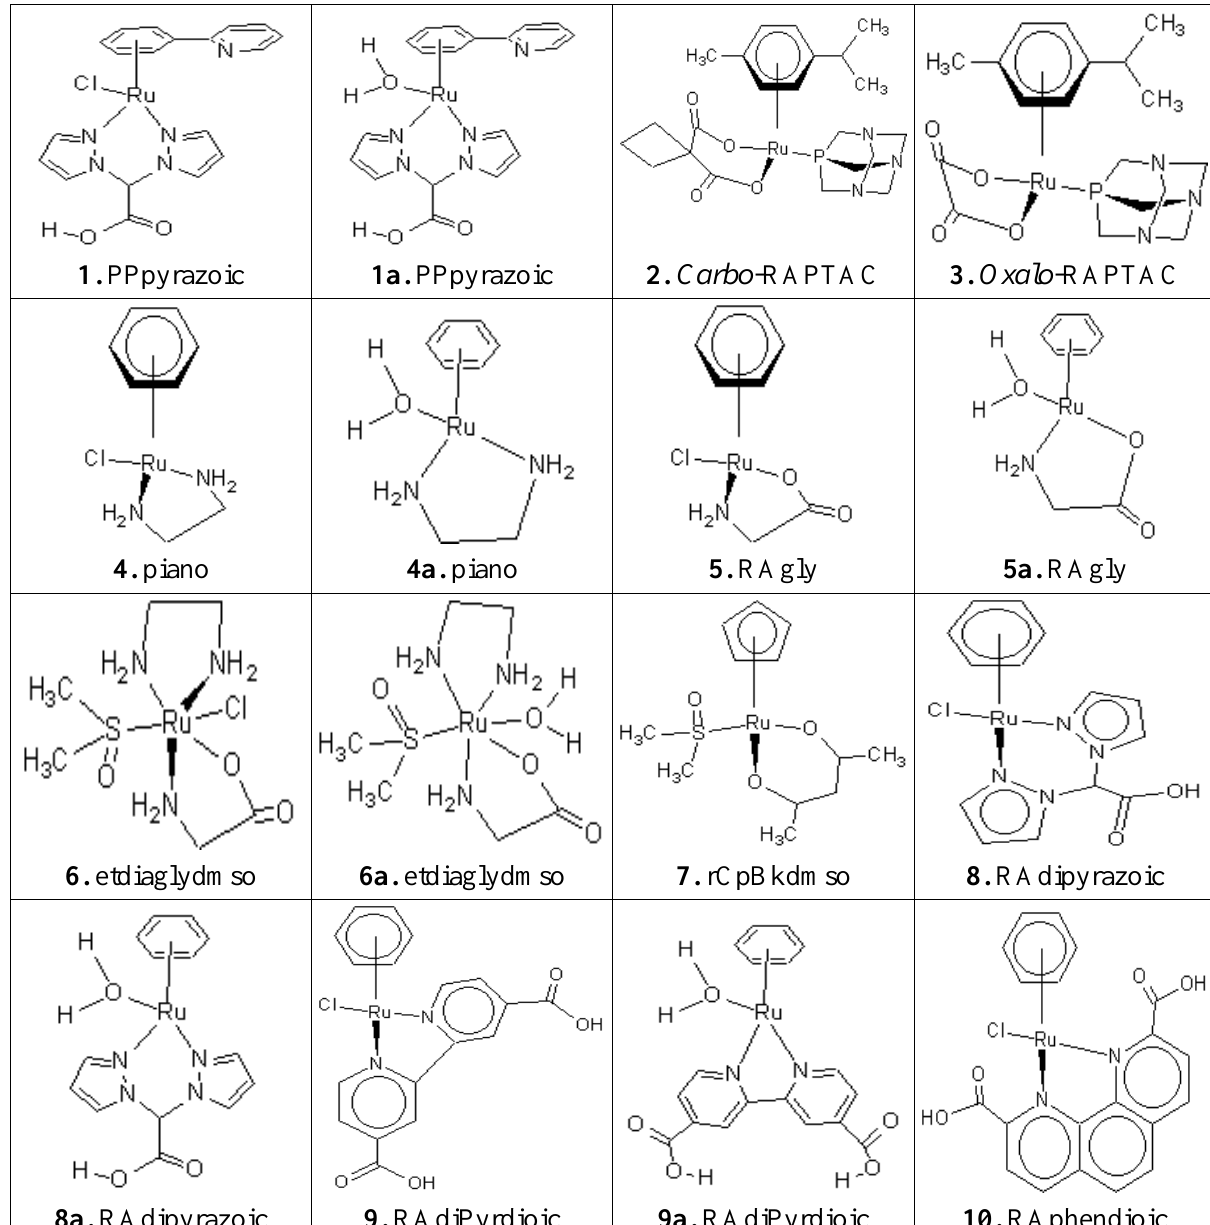
Figure 1. The schematic structures of the anticancer metal-based